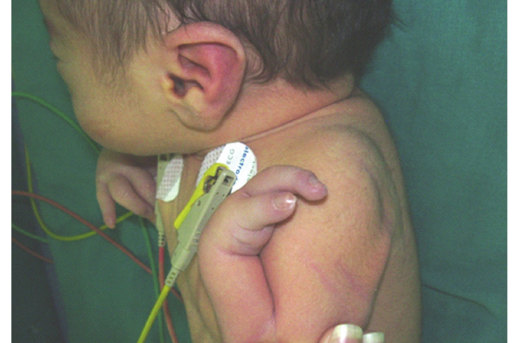
Figure 2: Right and left hands. Note the fusiform appearance of fingers and hyperconvex nail with a curvature towards hypoplastic pulps.